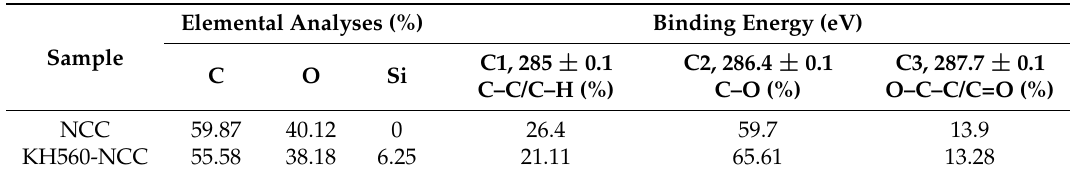
Table 1. XPS analysis of NCC and